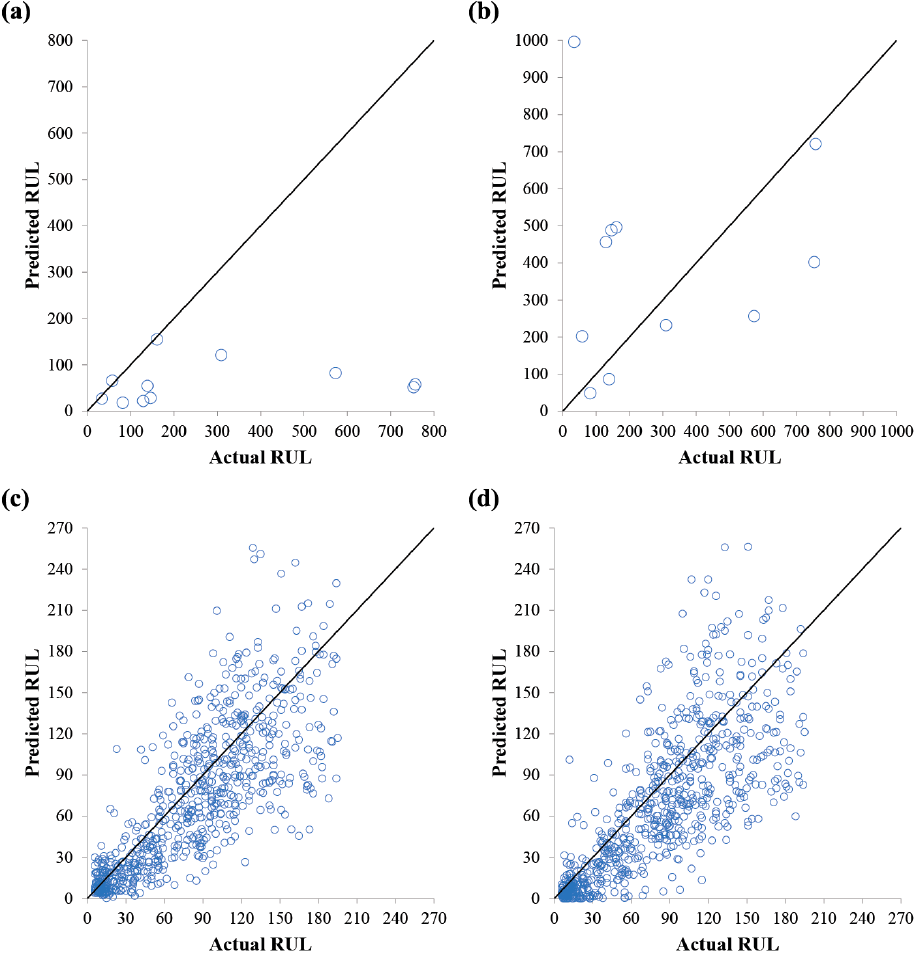
Figure 3. Scatter plots of the actual and predicted RULs by the MF-PCA approach. ( a , b ) results of MLP and RF, respectively, over the IEEE 2012 PHM dataset; ( c , d ) results of MLP and RF, respectively, over the NASA C-MAPSS dataset. Points below the diagonal line mean early predictions. Table 4. The numbers of principal components selected by PCA process in MF-PCA and SF-PCA approaches. The principal components that explain 99% of the data variance were selected. ( a ) IEEE 2012 PHM and ( b ) NASA C-MAPSS datasets. NuOF and NuPC stand for “the number of original features” and “the number of principal components selected”, respectively.